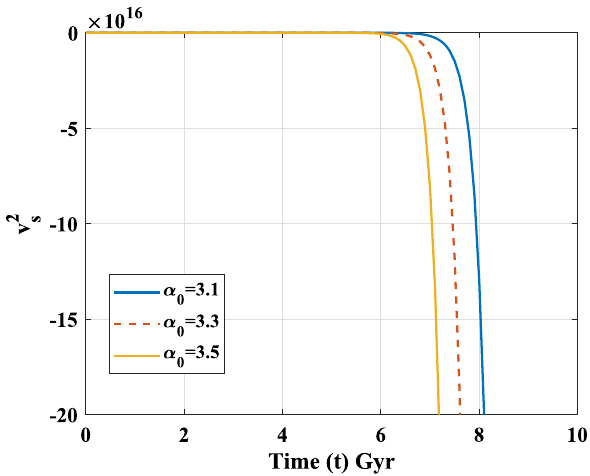
Fig. 8 Plot of EoS parameter ( ω T ) versus time ( t ) for k = 1 . 9, α 1 = 1 . 2, α 2 = 0 . 52, γ 1 = 101, and β = − 0 .